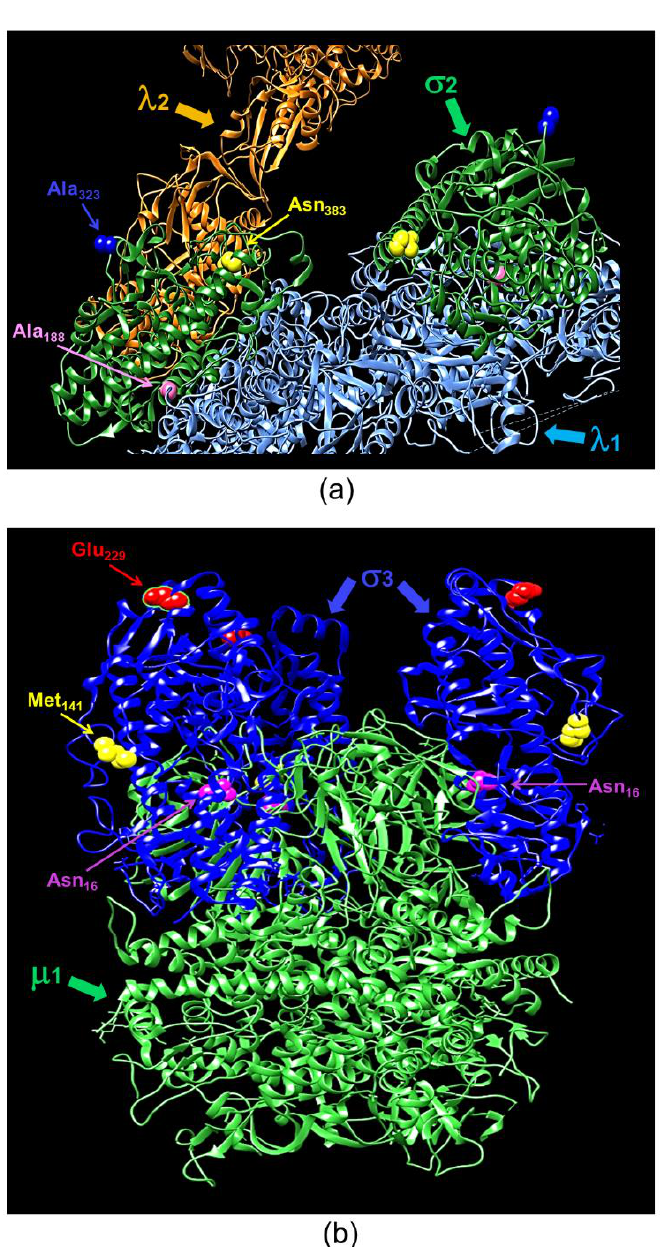
Figure 5. Ribbon tracings of the reovirus σ2 and σ3 proteins with annotated point mutation sites. ( a ) A mammalian reoviruses (MRV) core with T1L σ2 depicted in green. Residues altered in tsC447 are indicated. Ala 188 and Asn 383 are located near λ1 (light blue), and A 323 is located near λ2 (orange). ( b ) A heterohexamer assembly of T1L σ 3 and µ 1. Locations of tsG453 mutations are indicated on each of the three σ 3 monomers (in blue). Asn 16 is located near the σ 3 interface with µ 1 (green), Met 141 is located adjacent to several unstructured loops on the lateral surface of σ 3, and Glu 229 is located on the apical surface of σ 3. A lysine substitution at Asn 16 is postulated to alter σ 3 contacts with the neighboring µ 1 protein. Ribbon tracing images were produced using PDB 1EJ6 ( λ 1- λ 2- σ 2) and PDB 1JMU ( µ 1- σ 3) and UCSF